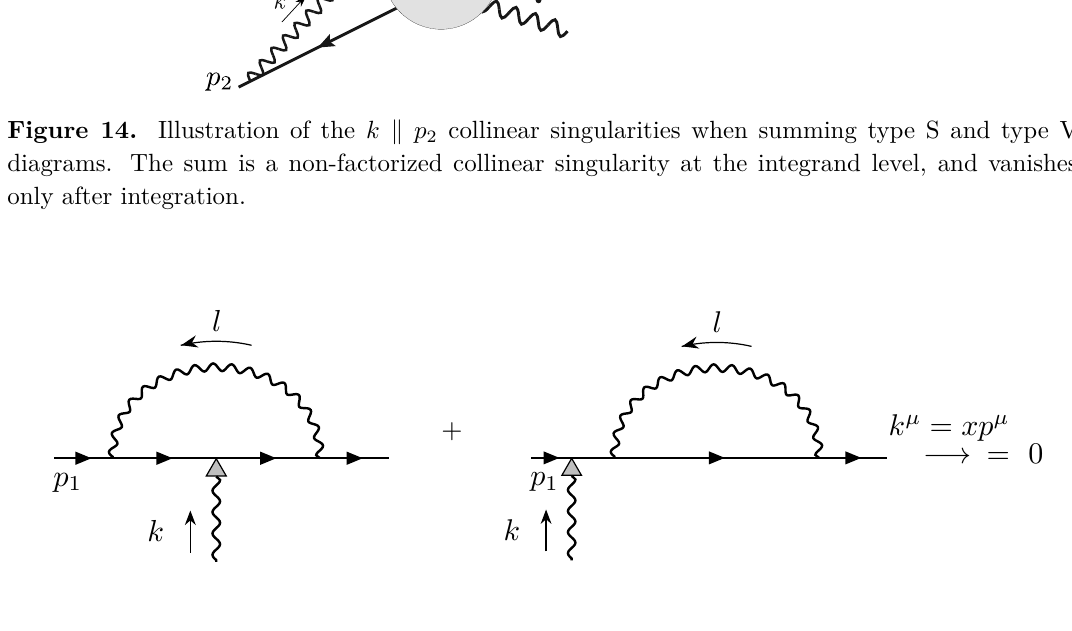
Figure 15. The exchange photon Ward identity for the modified integrands. This figure should be contrasted with figure 14 for the unmodified integrands, where the right-hand side is nonzero